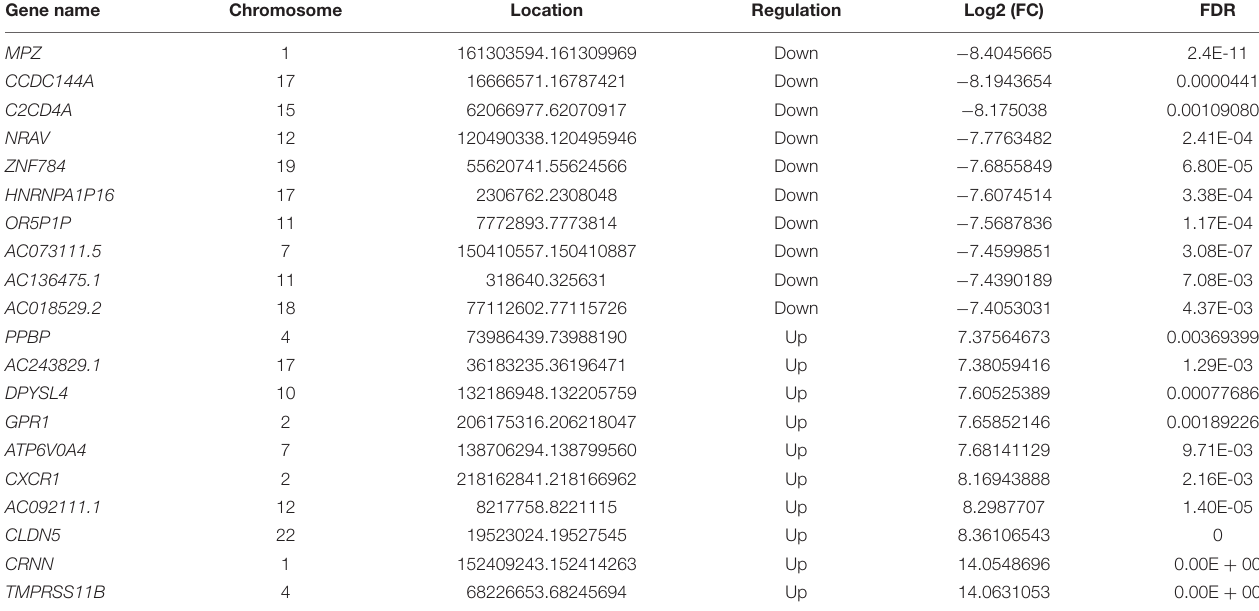
TABLE 2 | Top 20 differentially expressed genes in pterygium vs conjunctiva after